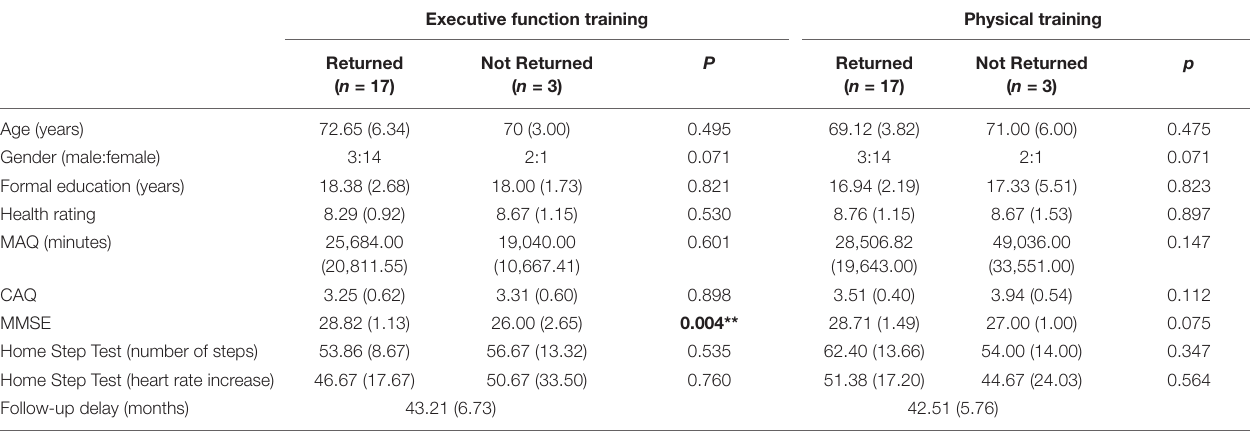
TABLE 1 | Baseline demographic information of those who returned for the follow-up vs. those who did not (i.e., not returned) across the executive function and physical training groups. Executive function